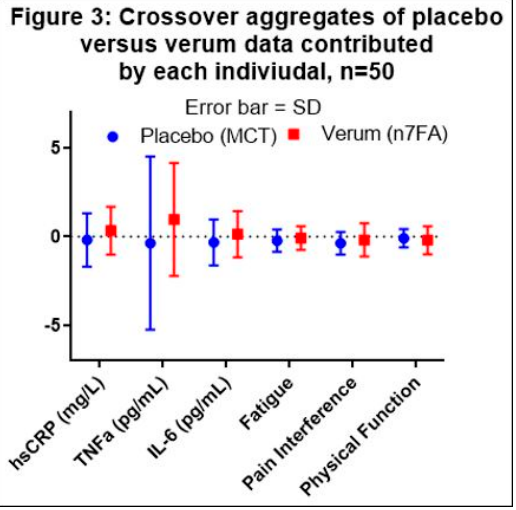
Figure 3. GA graphical presentation of Table 2. . shows that Medium Chain Triglycerides (MCT) Figure 3. Graphical presentation of Table 2. Medium Chain Triglycerides (MCT) demonstrate a demonstrateshowed a consistent anti-inflammatory lowering effect compared tothan the omega-7 consistent anti-inflammatory effect compared to omega-7 fatty acid (n7FA). The error bars rep- fatty acid (n7FA). The error bars showrepresent the standard deviation (SD). AllNone of the resent the standard deviation (SD). None of the comparisons between placebo and verum were comparisons between placebo and verumchanges were not statistically significant. statistically